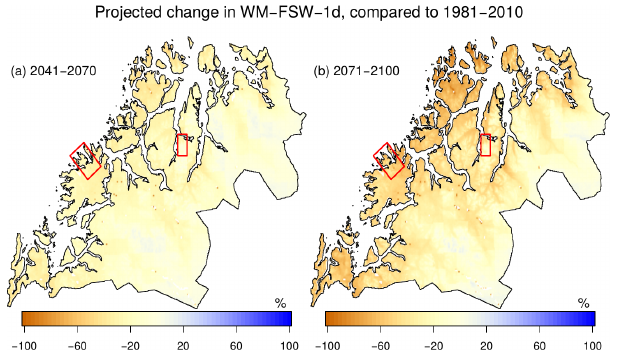
Figure 11. Projected change in the frequency of 1d snowfall ex- ceeding 5mm during winter (October–April) between 1981–2010 and (a) the near future (2041–2070) and between 1981–2010 and (b) the far future (2071–2100), based on fresh snow water equiva- lent for 1d duration (FSW-1d >